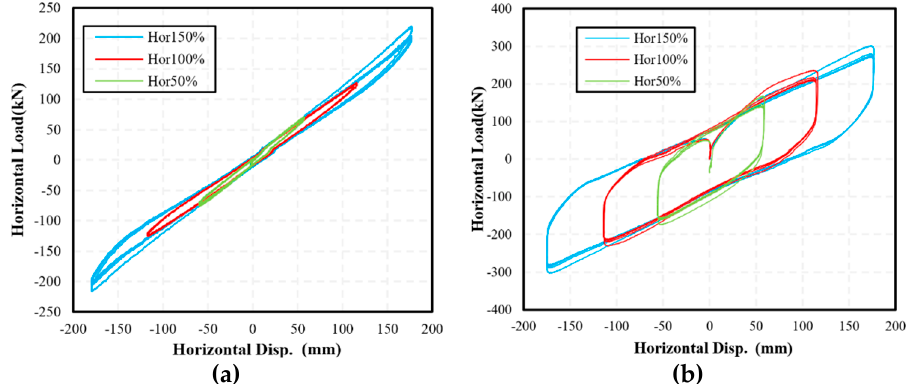
Figure 7. The deformation of specimens under horizontal loads: ( a ) NRB ‐ 600; ( b ) LRB ‐ 600. Table 4. Mechanical properties of the specimen obtained in the vertical compression tests.